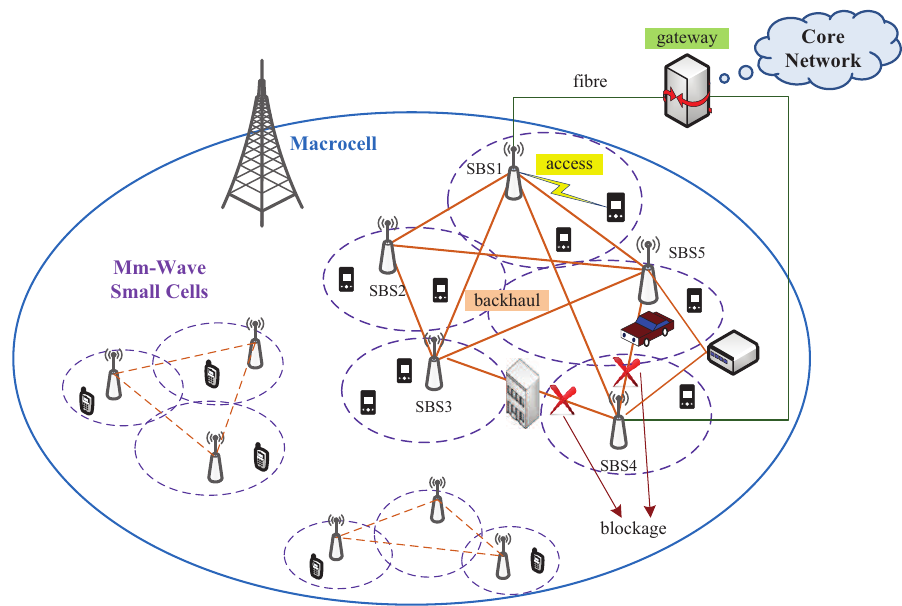
Figure 1. System overview for 5G mm-wave